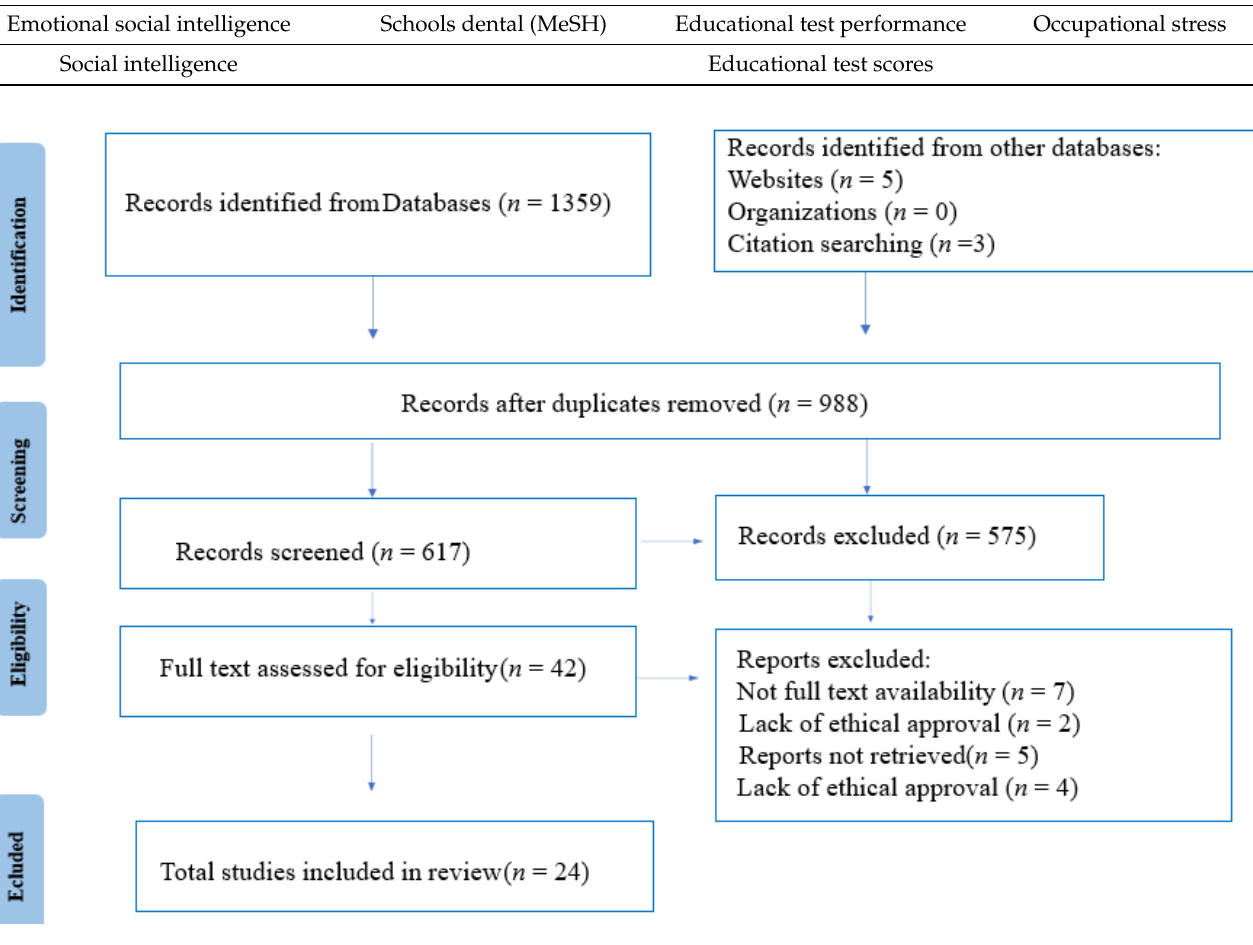
Figure 1. PRISMA Flowchart.